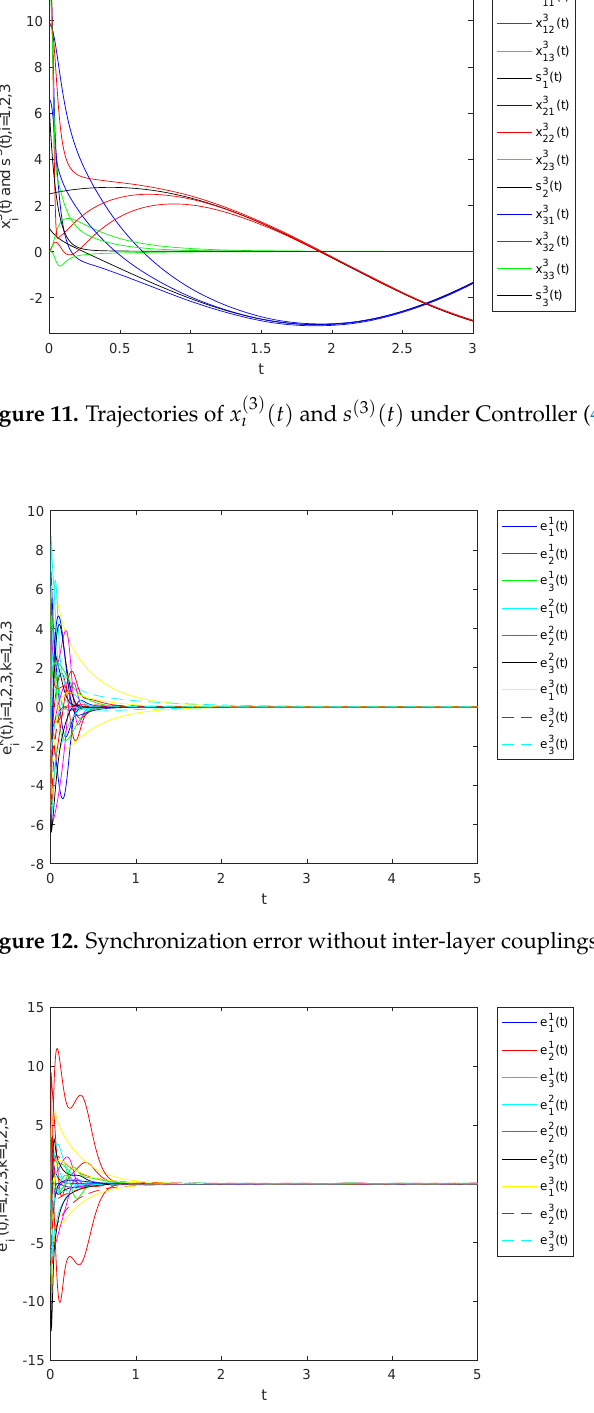
Figure 13. Synchronization error without intra-layer couplings under Controller